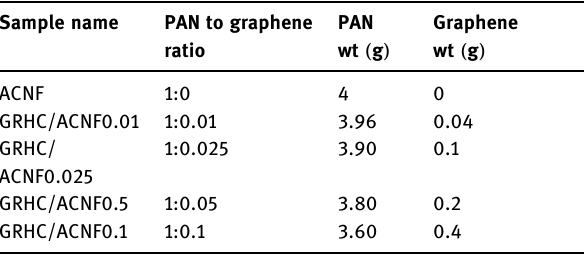
Table 1: Dope formulation of ACNFs with di ff erent graphene load - ings of 50 mL